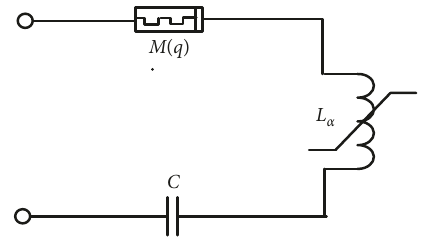
Figure 11: The memristor-capacitor circuit with parasitic frac- tional